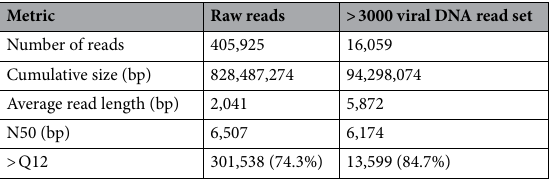
Table 1. Read metrics of sequencing before and after non-viral DNA removal.